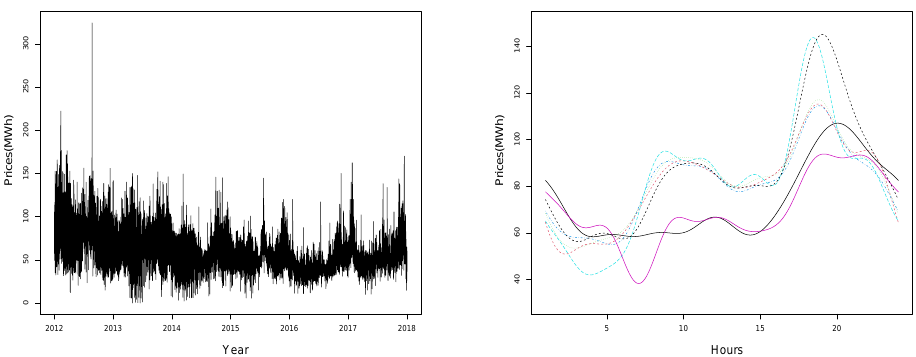
Figure 2. Electricity prices: ( left ) the original time series of 52,608 hourly electricity spot prices and ( right ) electricity prices smoothed curves for one